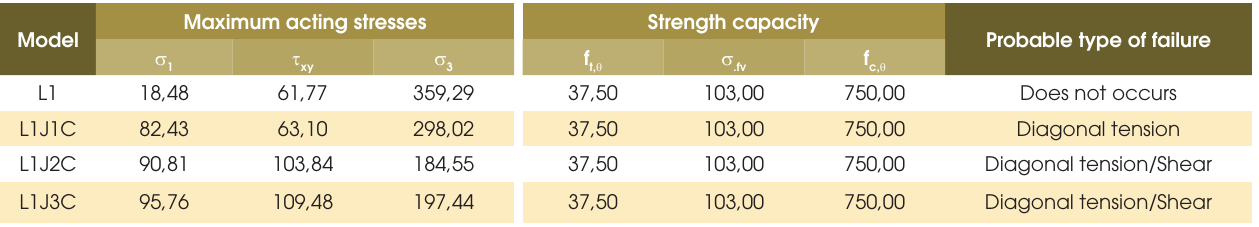
Table 7 – Summary of the results of the Example 2 – Maximum Acting Stresses vs. Strength (kN/m 2 )